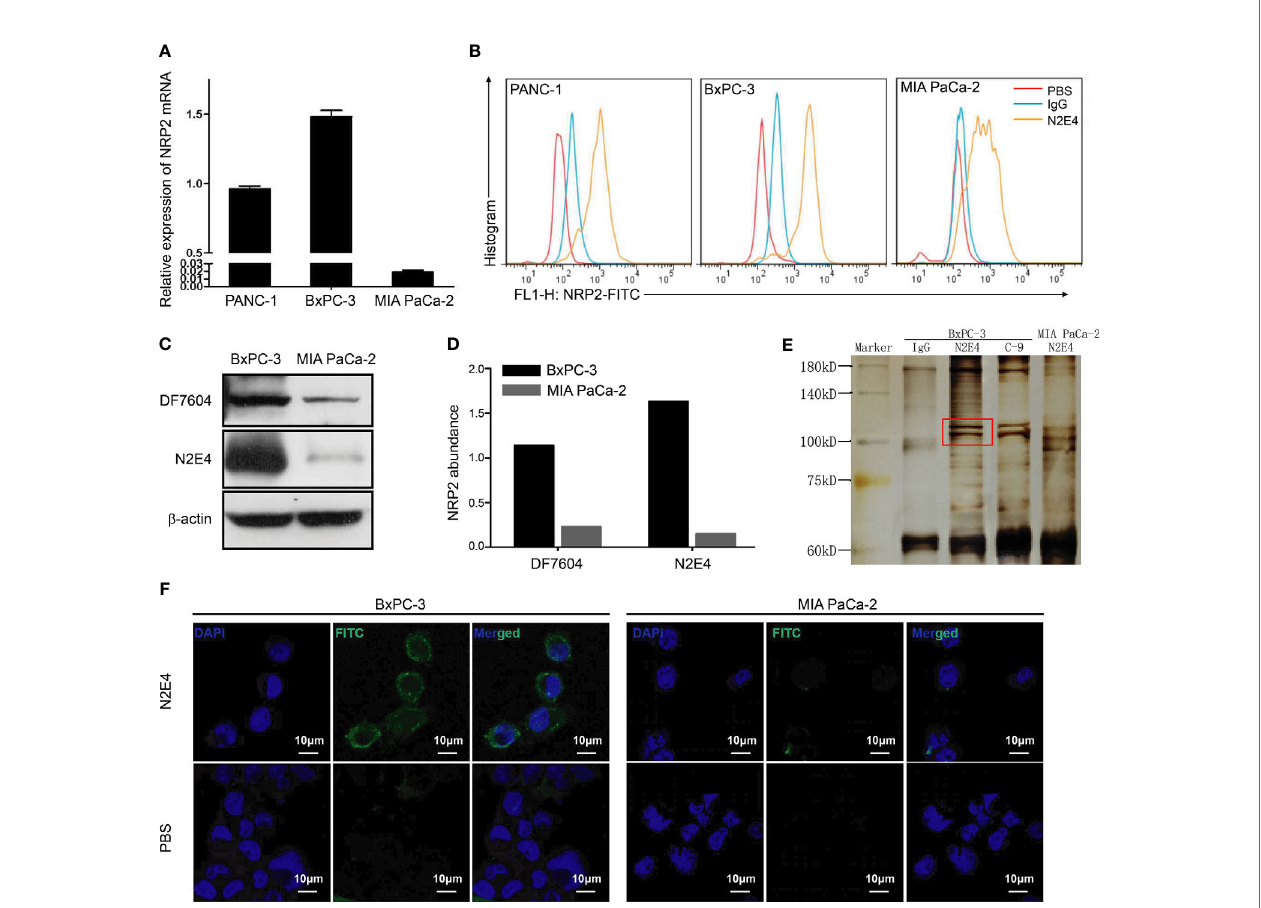
FIGURE 2 | N2E4 combines the membrane-associated NRP2 in PDAC cells. (A) Nrp2 gene was detected by RT-PCR in pancreatic ductal adenocarcinoma cell lines PANC-1, BxPC-3, and MIA PaCa-2. (B) The binding capability of N2E4 to NRP2 expressed on cells was showed using fl ow cytometry. (C) NRP2 expression and the af fi nity of N2E4 were further evaluated using western blotting, and (D) NRP2 abundance was calculated by Image J. (E) After immunoprecipitation by N2E4 antibody, the N2E4-NRP2 complexes were separated by SDS-PAGE gel. C-9 antibody is the positive control, IgG is the negative control. (F) The binding of N2E4 directly in BxPC-3 and MIA PaCa-2 using immuno fl uorescence, representative images of cells obtained at ×1200 magni fi cation was